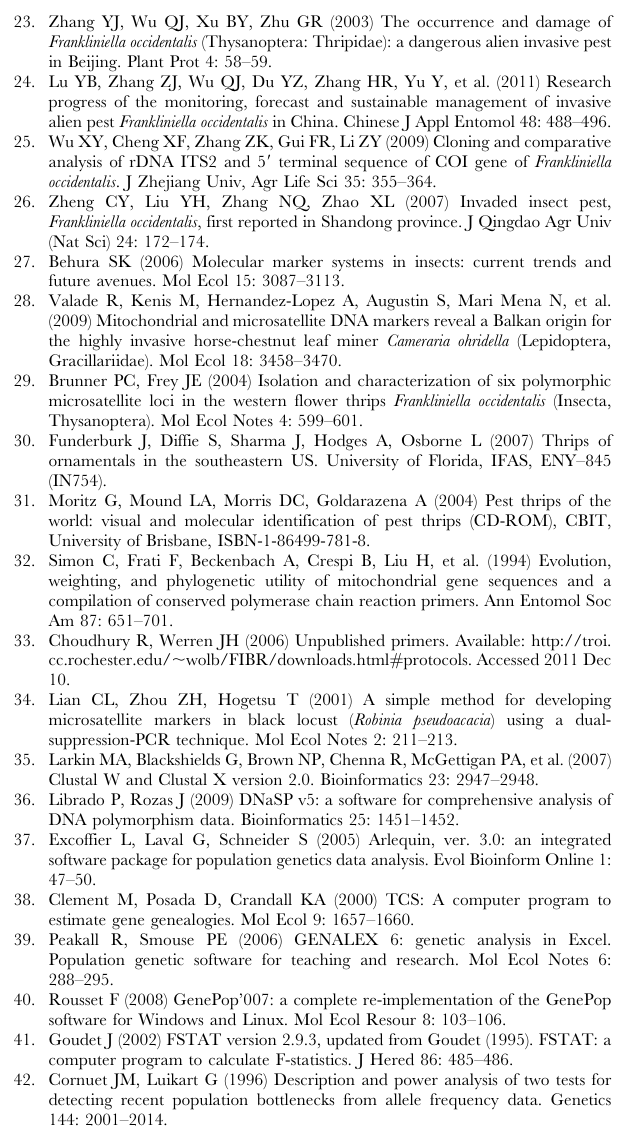
Table S5 Within-population tests for heterozygosity excess P- values. Table S6 Results of AMOVA test on mitochondrial and microsatellite